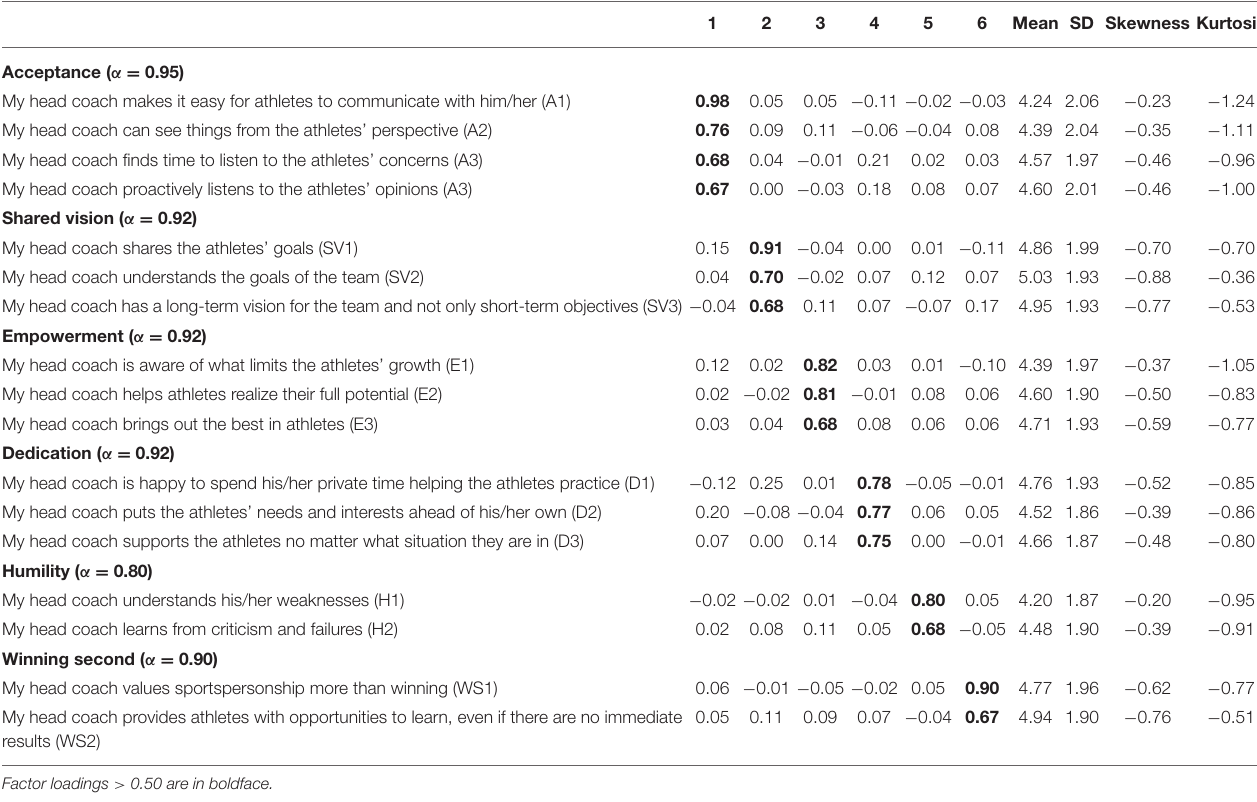
TABLE 2 | Results of exploratory factor analysis and descriptive statistics.